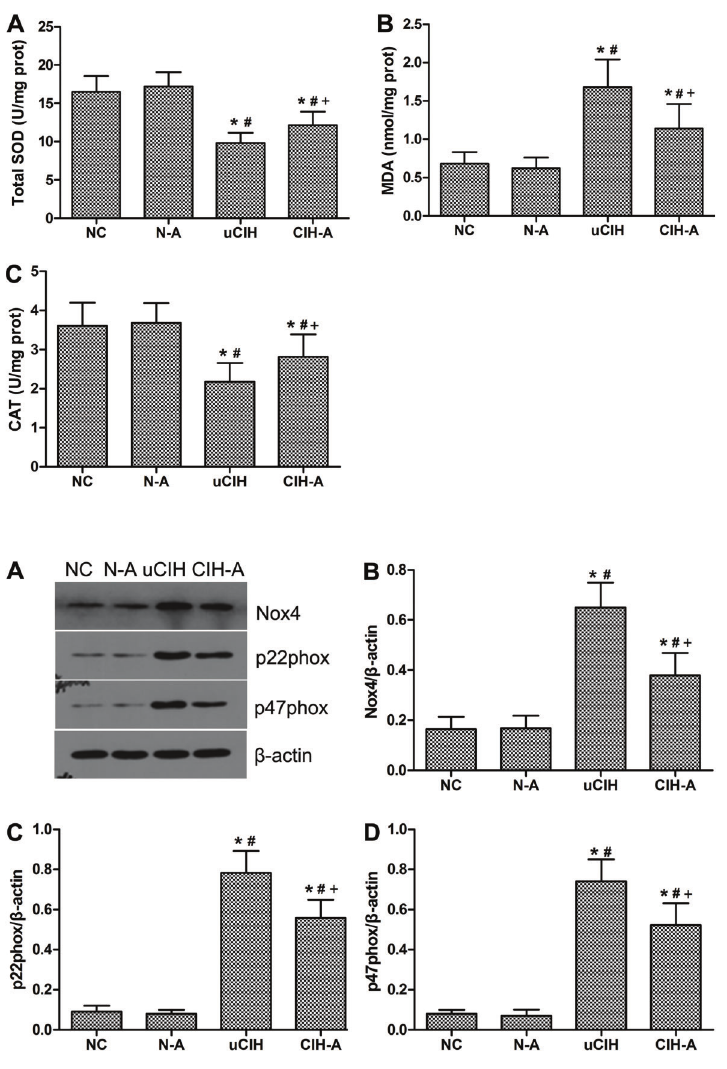
Figure 4. Ang-(1 – 7) reduced oxidative stress in lung tissues. A , Total SOD activity; B , MDA content; C , CAT level. Results are reported as means ± SE (n=8 rats per group). NC: normoxia control group; N-A: NC and Ang-(1 – 7) supplemented group; uCIH: untreated chronic intermittent hypoxia group; CIH-A: